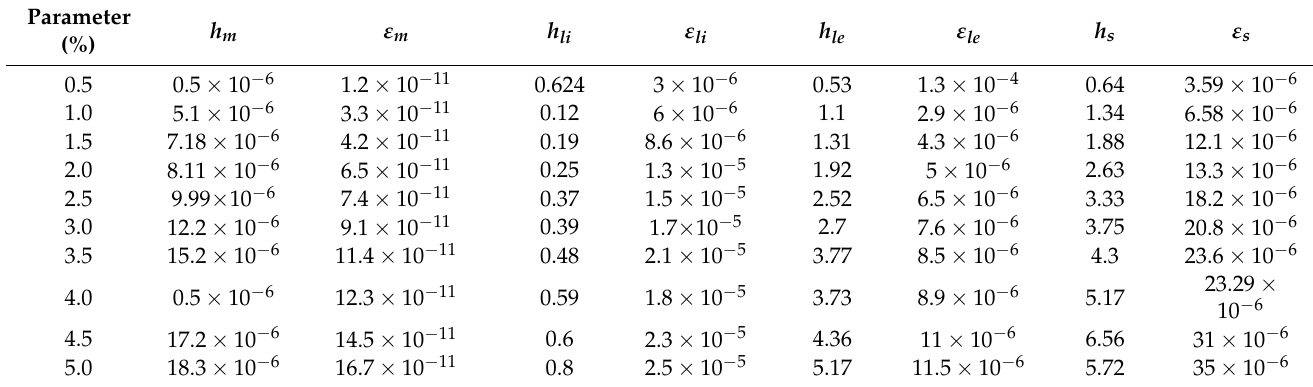
Table 3. Monte Carlo sensitivity analysis.